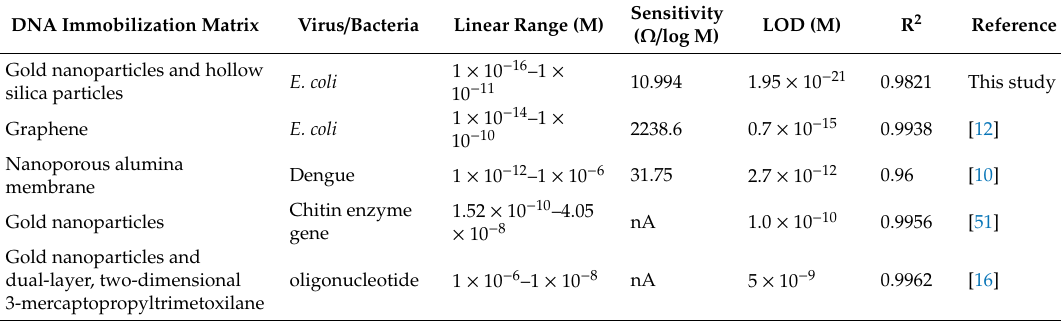
Table 3. Comparison between the constructed biosensor with the other biosensors using the impedimetric technique. LOD, limit of